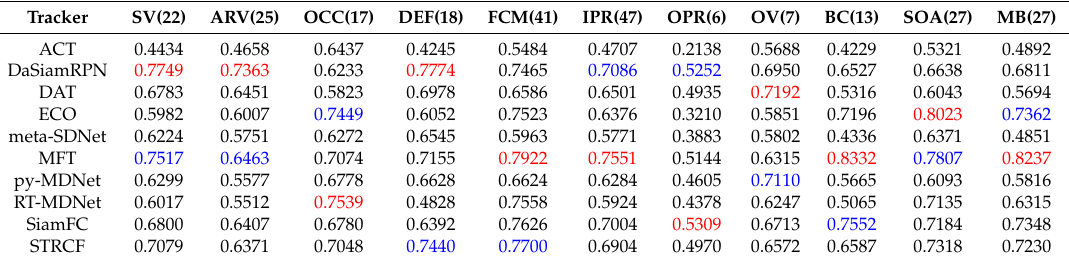
Table 7. Precision results on various DTB70 dataset attributes listed in Table 1. Top performing tracker is shown in red and the second-best performing tracker is shown in blue. Best viewed in color.